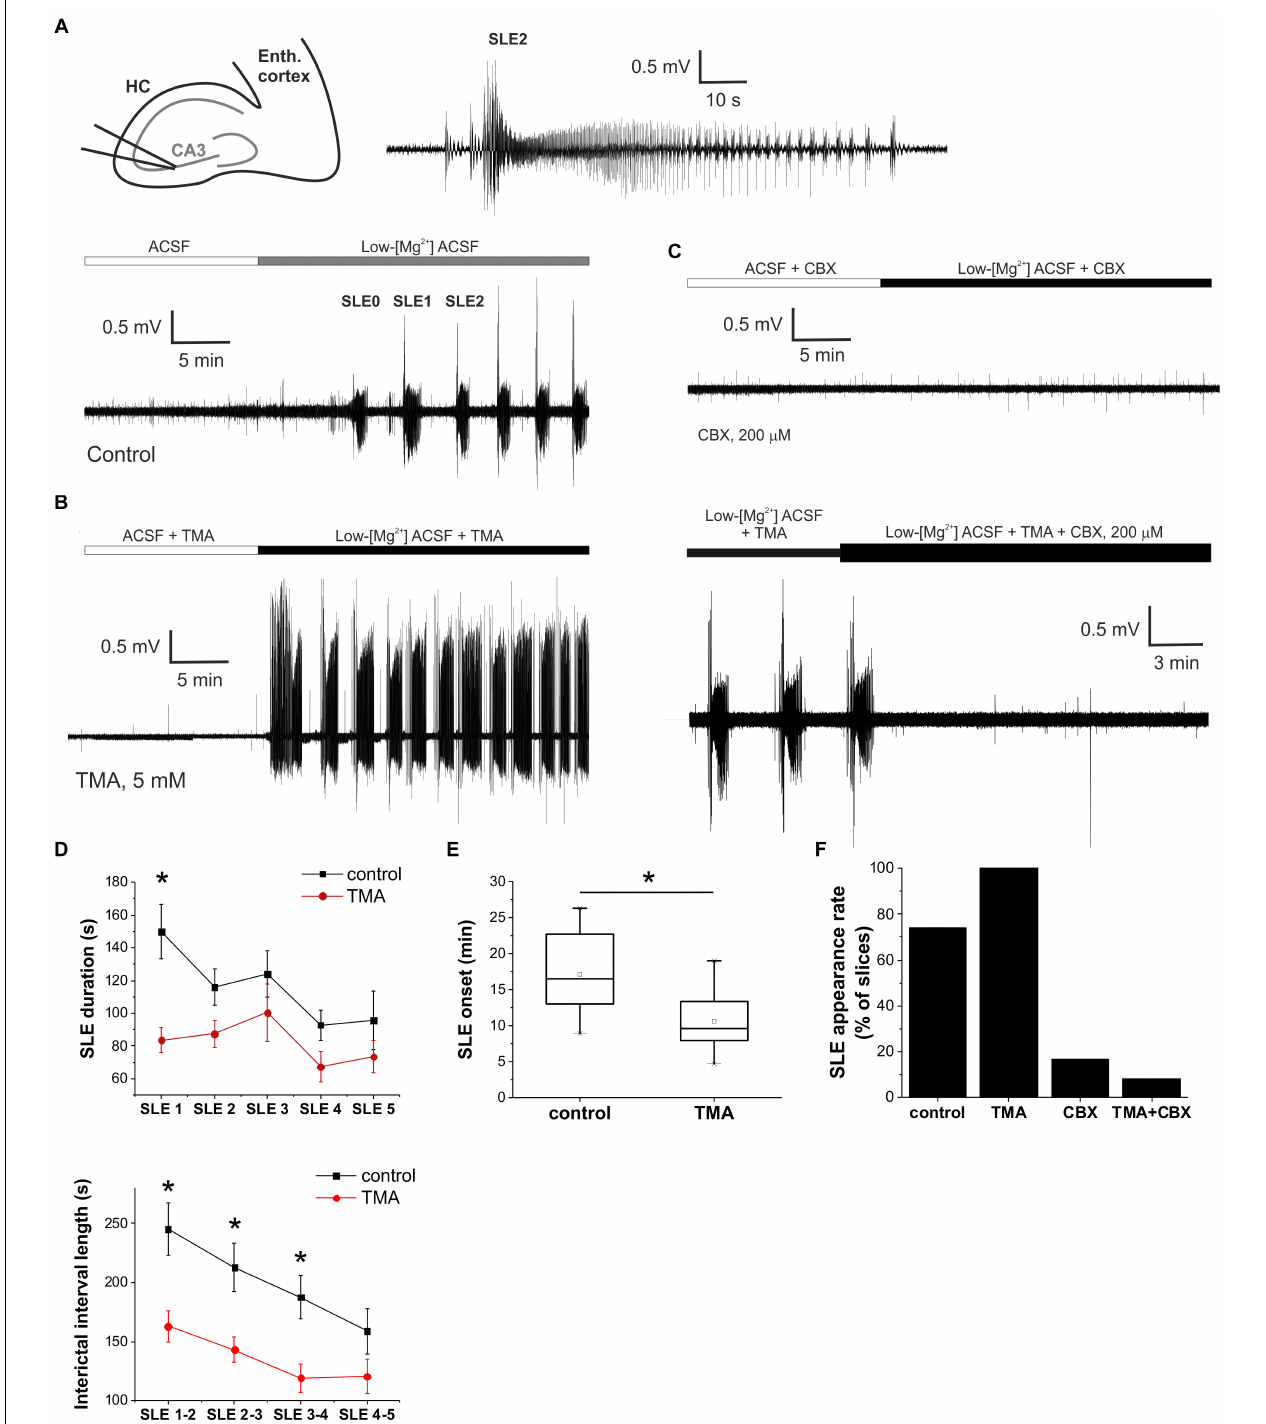
FIGURE 1 | Gap junction activation enhances, gap junction inhibition suppresses epileptiform activity in vitro in the low-[Mg 2 + ] TLE model. (A) Extracellular field potential (FP) recording of recurrent seizure-like events (SLEs) induced by low-[Mg 2 + ] ACSF in the CA3 region of a hippocampal slice (top left). SLE2 is shown in higher temporal resolution (top right). (B) Extracellular FP recording of SLEs in the presence of 5 mM trimethylamine (TMA). (C) Extracellular FP recording in the presence of 200 µ M carbenoxolone (CBX). CBX was applied either before the application of the low-[Mg 2 + ] medium (top) or following the fully developed SLEs in the presence of 5 mM TMA (bottom). (D) Average duration of SLEs (top) and interictal periods (bottom) in control conditions (black) and in the presence of 5 mM TMA (red). Asterisks denote significant differences ( p < 0.05) between control conditions and TMA application. (E) Onset of first SLE in control conditions and in the presence of 5 mM TMA. Application of TMA significantly decreases SLE onset. (F) Percentage of slices in which low-[Mg 2 + ] ACSF induced SLEs.